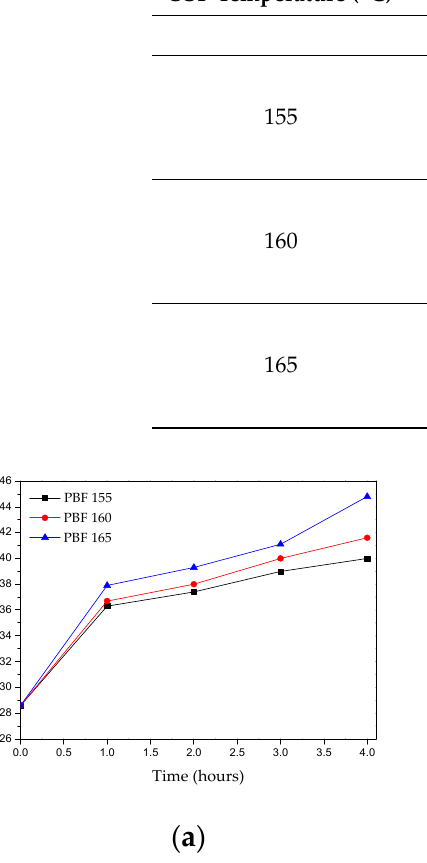
Figure 9. Evolution of the crystallinity degree (X c ) with time and temperature of SSP for ( a ) PBF and ( b )